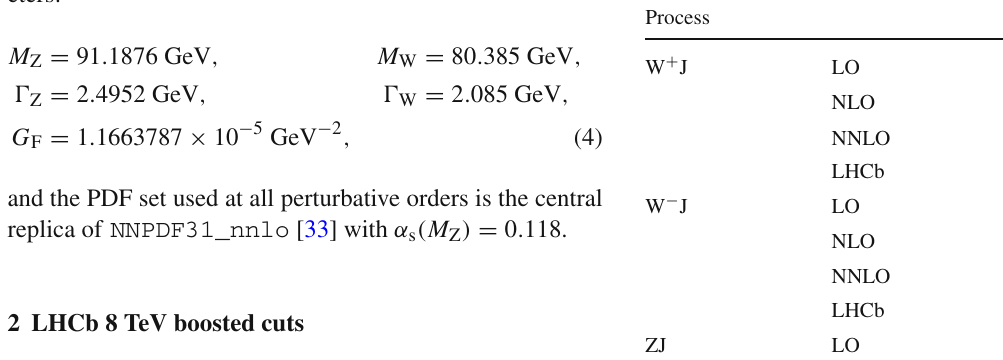
Table 1 Fiducial cross sections for fixed order theory predictions and LHCb results from Ref. [16]. The errors quoted for NNLO JET corre- spond to the scale uncertainty and the reported LHCb errors are statis- tical, systematic and luminosity